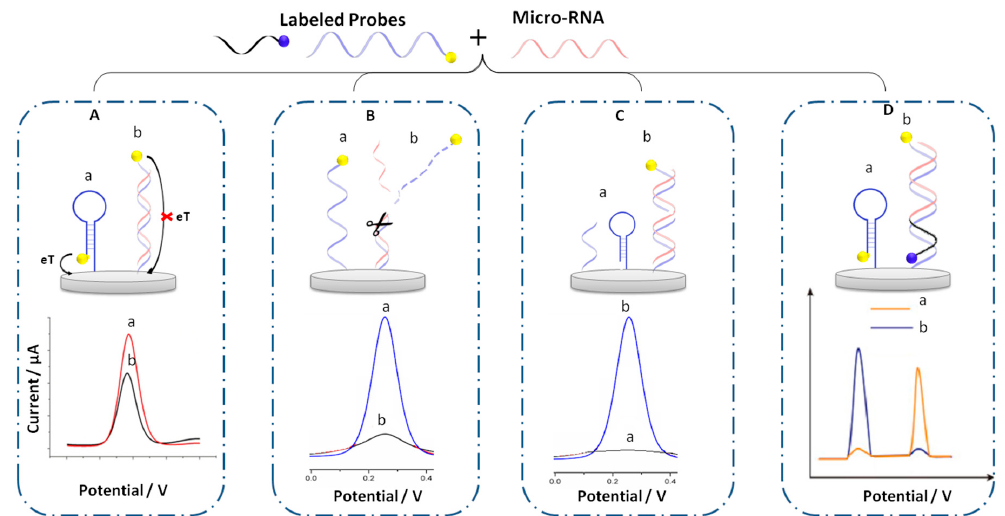
Figure 1. Di ff erent architecture of electrochemical biosensors based on labeled probe with RedOx molecules before and after hybridization. ( A ) Basic design; ( B ) elimination of labeled probe sequence; ( C ) the use of secondary probe labeled with RedOx molecule; ( D ) the use of two-probe labeled sequence, ( a ) before and ( b ) after hybridization.